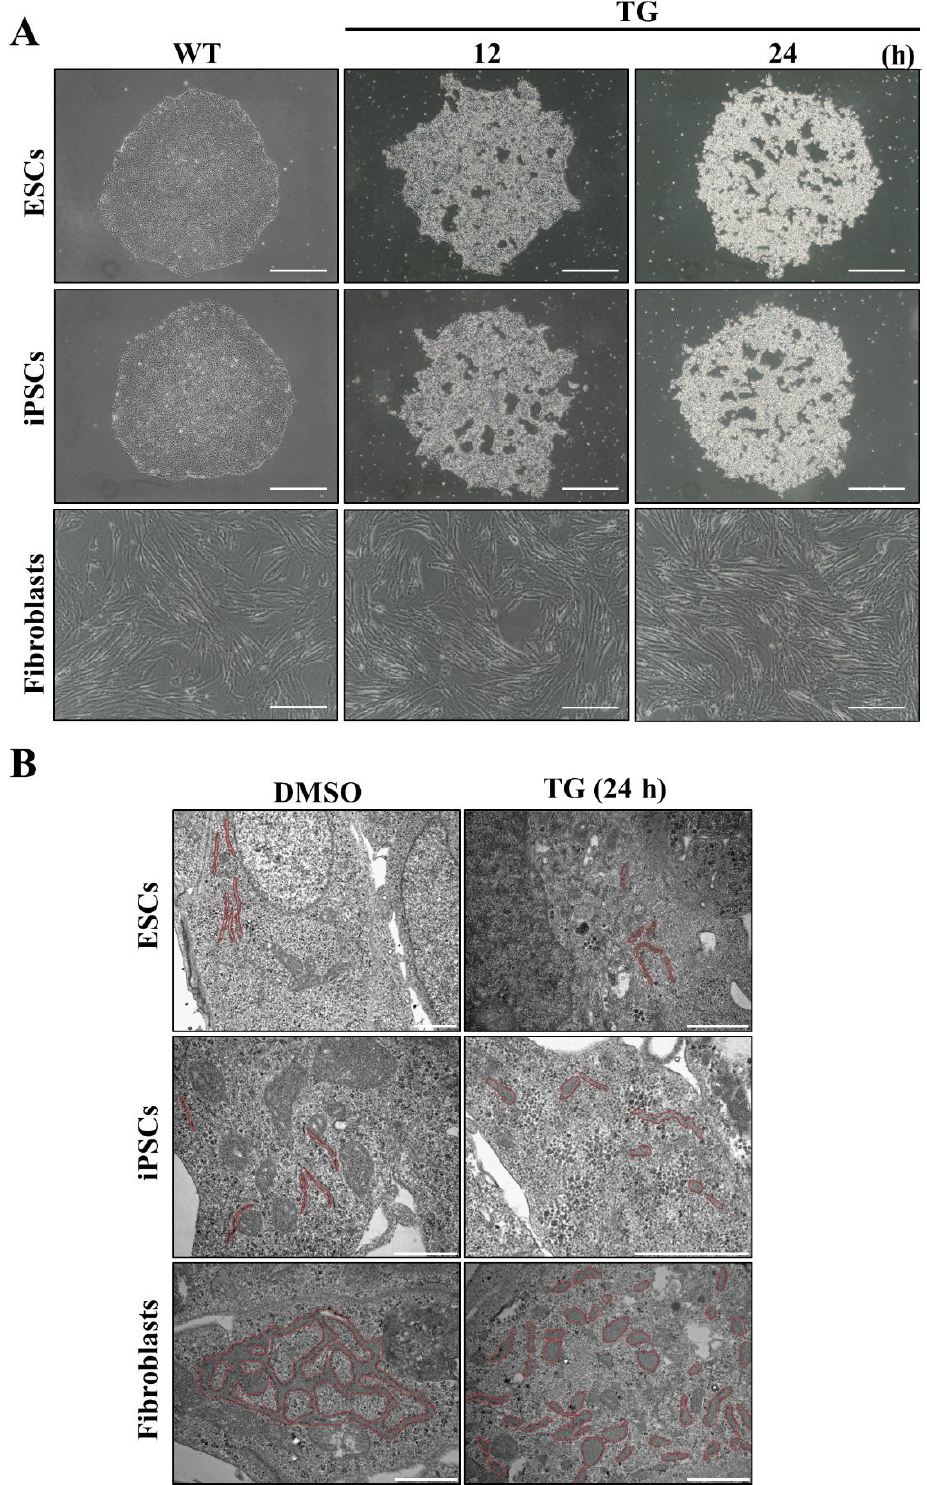
Figure 3. Unfolded protein response (UPR) induction under ER stress caused by thapsigargin (TG) treatment. ( A ) Morphological changes in the cell population in response to ER stress observed using an optical microscope. (WT, TG treatment for 12 or 24 h). Scale bar: 200 µ m ( B ) Morphological changes in the ER structure under dimethyl sulfoxide (DMSO) or TG treatment conditions; Red line indicates the ER structure in hPSCs. Scale bar: 1 μm.